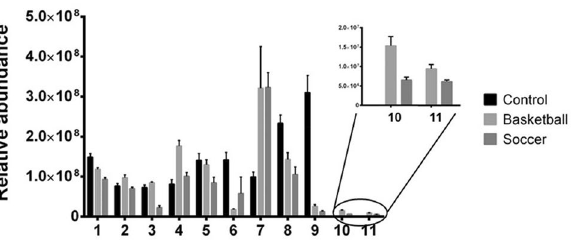
Figure 2. Plasma metabolomic profile using GC–MS analysis. Histogram representation of plasma metabolites whose relative abundance is statistically different among control, soccer and basketball groups, all p-value details are re-ported in Table 2. Numbers of abscissa axis correspond to metabolites as reported in Table 2. All the measurements were performed in triplicate and are reported in the histograms as mean ± SD.